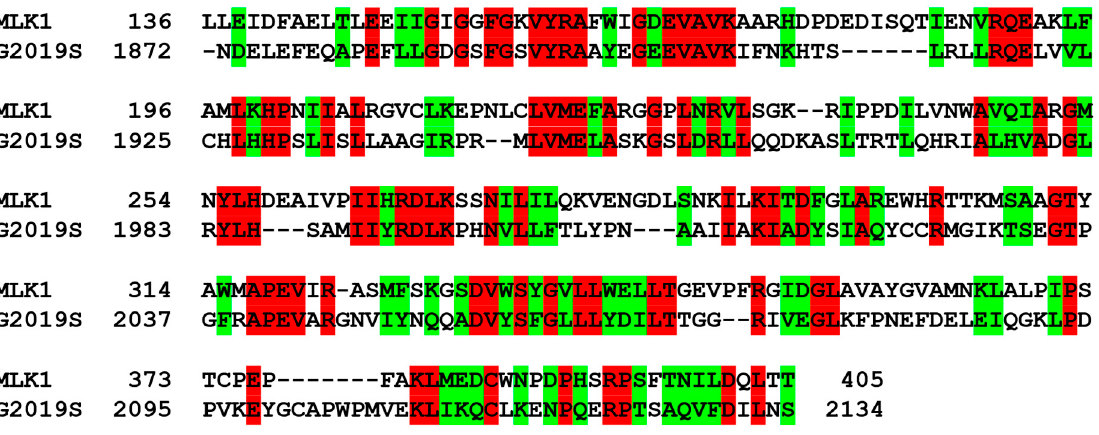
Figure 1. Amino-acid sequence alignment between the kinase domains of MLK1 and the G2019S mutant of LRRK2. Identical and similar residues are colored in red and green, respectively.